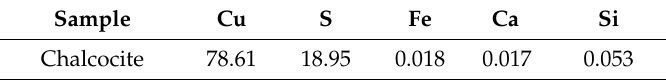
Figure 1. Synchrotron radiation X-ray diffraction (SRXRD) results of synthetic chalcocite samples (BSRF). Table 1. Chemical compositions analysis results of chalcocite (%).